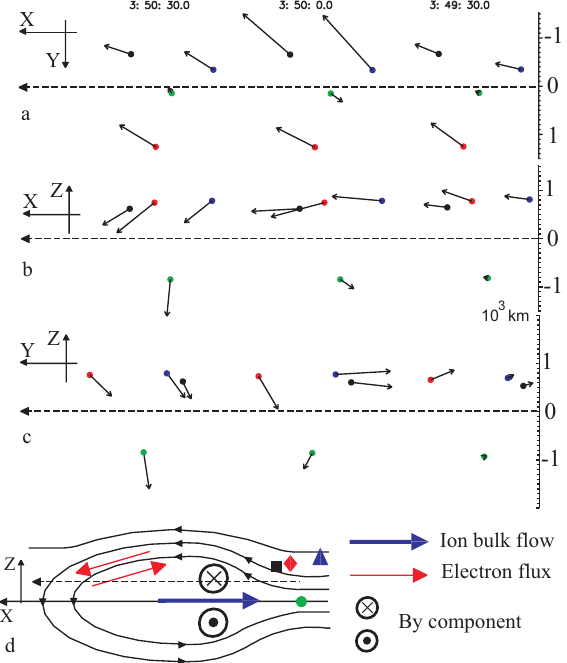
Fig. 11. Interval B : Projections of the magnetic field at the four s/c (black arrows) onto XY (a) , XZ (b) , and YZ (c) GSM planes at three successive instances. Panels d presents the interpretation cartoon.